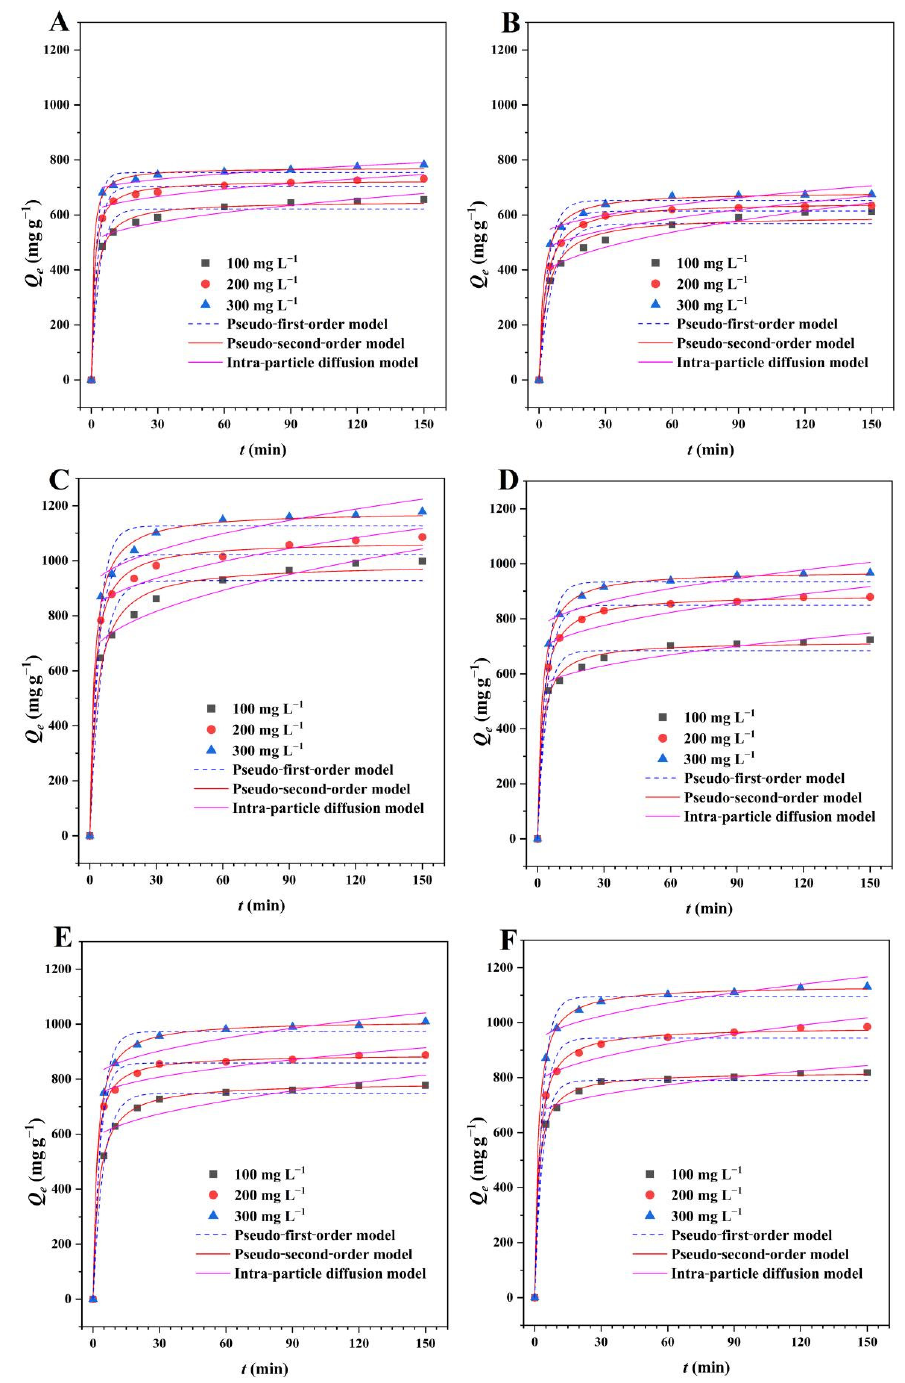
Figure 6. The adsorption kinetic plots of ( A ) BMCD-K, ( B ) BMCD-Na, and ( C ) BMCD-MB for RhB. The adsorption kinetic plots of ( D ) BMCD-K, ( E ) BMCD-Na, and ( F ) BMCD-MB for TH.